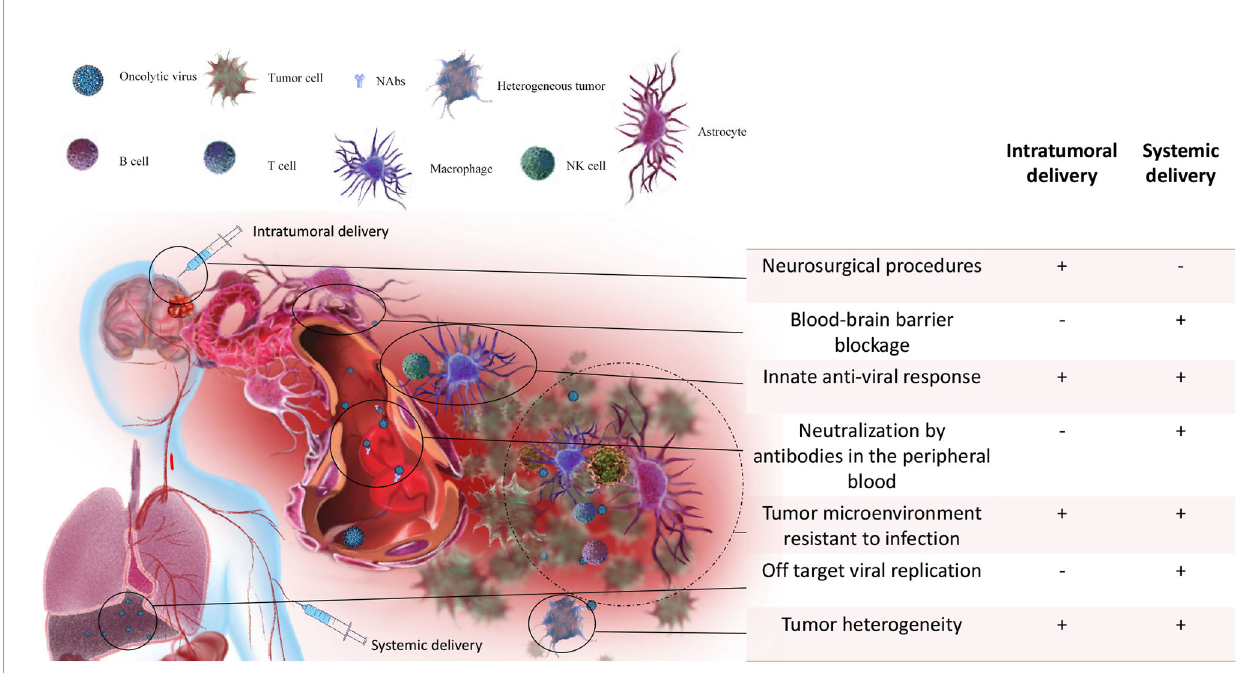
FIGURE 3 | Obstacles to OVT of gliomas via intratumoral and systemic delivery. For intratumoral delivery only, 1) the expense and complexity of neurosurgical procedures, limiting repeat administration. For systemic delivery only, 1) After injection, the fi rst challenge is neutralization of OVs by antibodies in the peripheral blood; 2) Off target effect is the second challenge for systemic delivery since OVs may not be able to reach to the brain and cause infection to normal tissue (e.g. liver); 3) even if OVs can reach to the brain, the intact BBB is able to block the passage of most viruses. For both intratumoral and systemic delivery, 1) Innate anti- viral response can prevent OVs from interacting with tumor cells; 2) the speci fi c tumor microenvironment is also resistant to OVs infection and suppresses the OVs- induced anti-tumor immune response; 3) tumor heterogeneity can make OVs insensitive to part of tumor